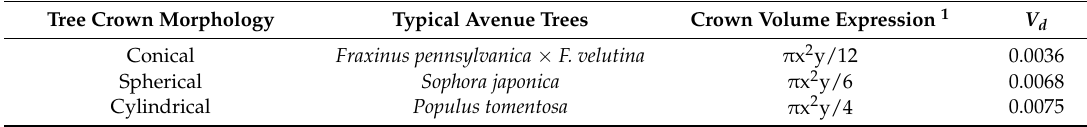
Table 3. Tree configuration